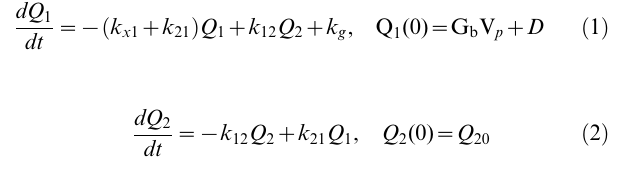
Figure1. Schematicrepresentation ofrenal anatomy, experimentalset-up,and modeling. Panel A reportsa schematicrepresentationofrenal anatomy and of the experimental set-up; panel B reports the schematic compartmental diagram of the Glycemia Model as well as of the Tubular System.